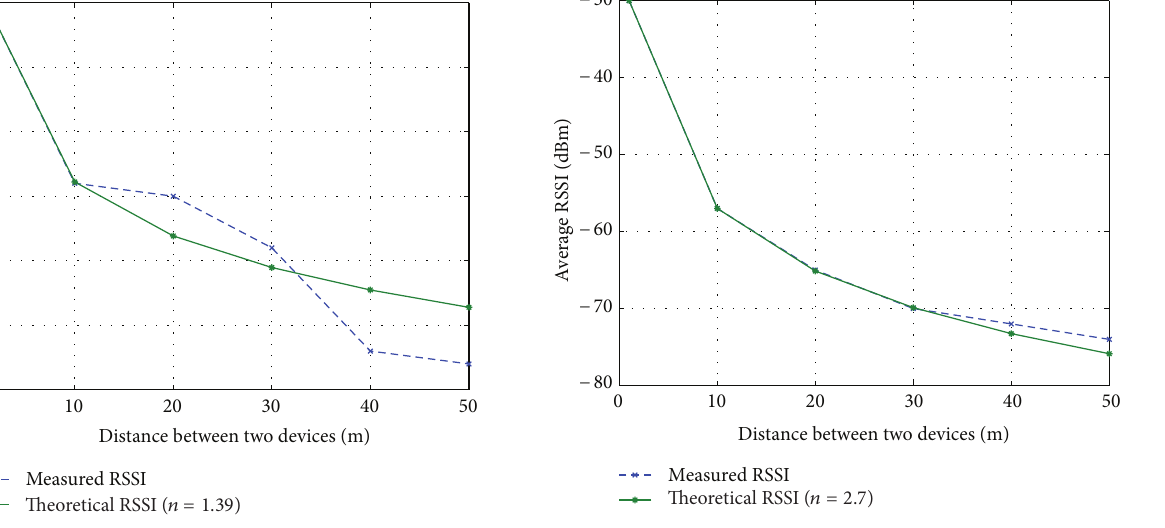
Figure 10: Measured RSSI (avg. of 1,000 samples) at various indoor spots.